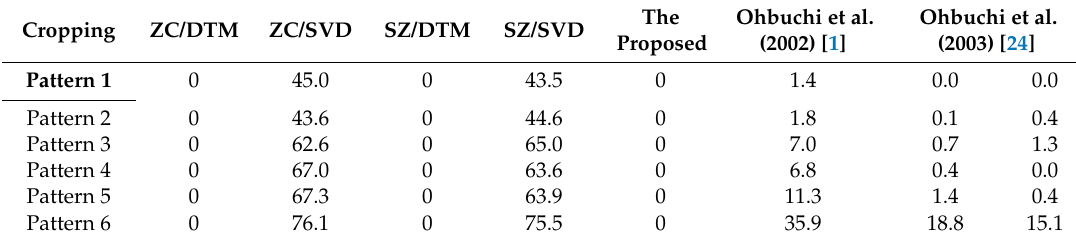
Table 5. Results of cropping attack